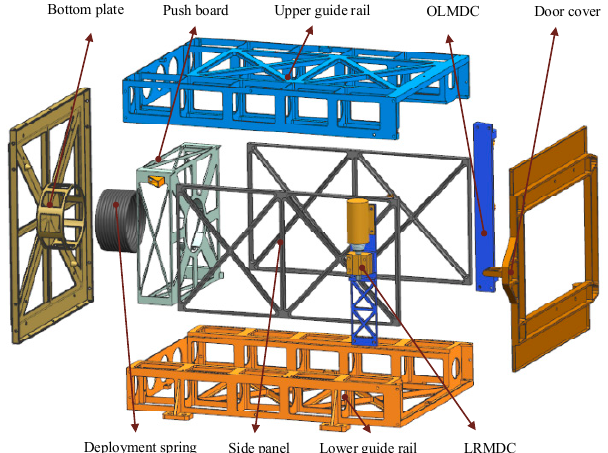
Figure 3. Exploded view of the separation mechanism.